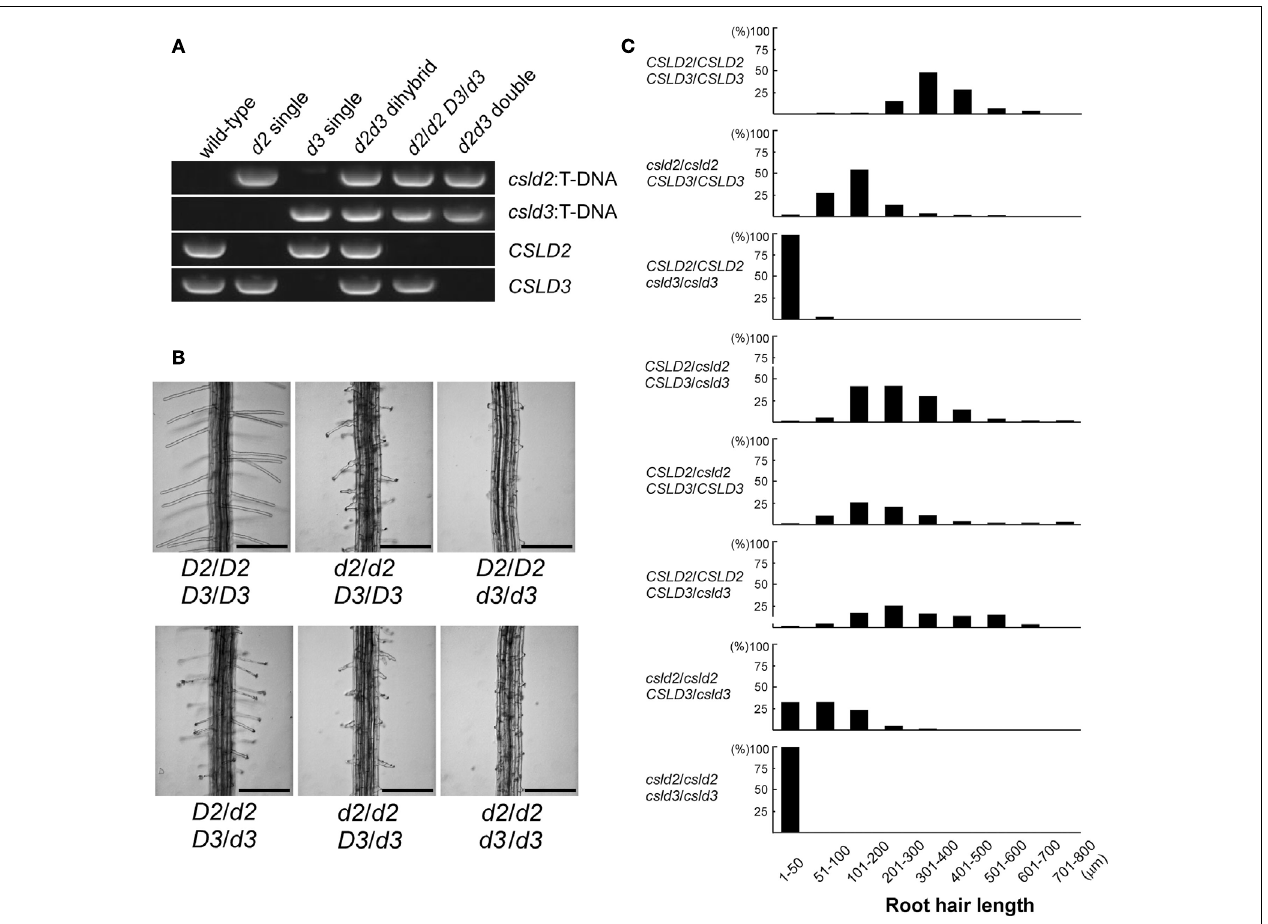
copies of the CSLD genes. Bars = 250 μ m. (C) Quantification of root hair length from individuals with different copies of the CSLD2 or CSLD3